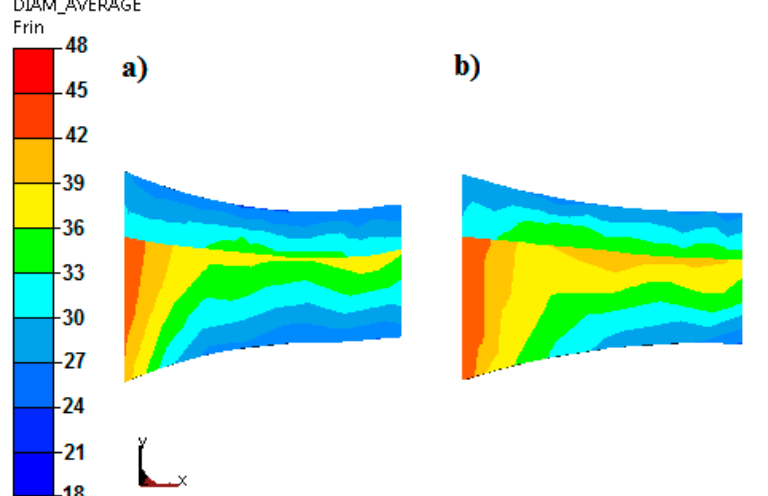
Figure 8. Average grain size distributions during rolling of bimetallic sheet metals X2CrNiMo17-12-2 + 10CrMo9-10 with relative deformation ε = 0.18 for: ( a ) a v = 0.75 and ( b ) a v = 1.0.